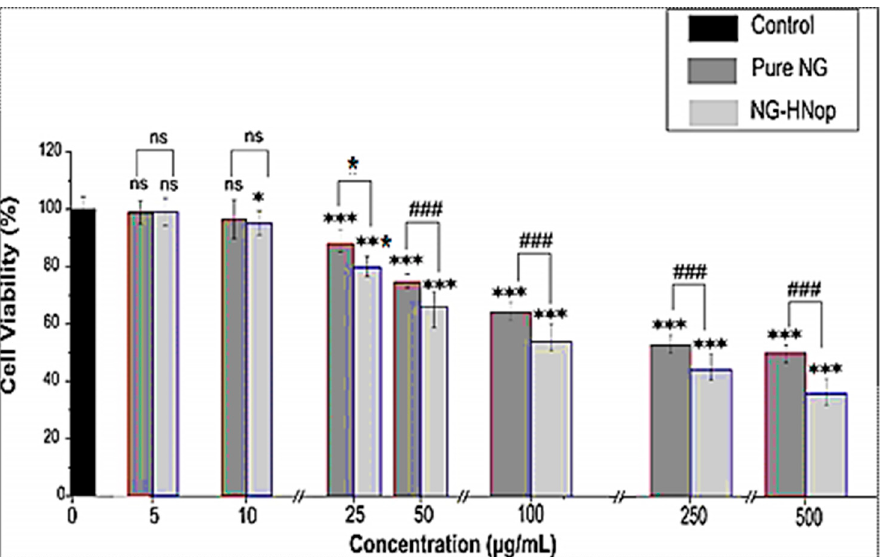
Figure 7. Cell viability activity of pure Naringin (NG) and Naringin hybrid nanoparticles (NG-HNop). The study was performed in triplicate and data are shown as mean ± SD. Statistical analysis was performed by Tukey–Kramer test. ***—Highly significant with respect to control; ###—highly significant with respect to pure NG; *—significant with respect to pure NG; ns—non-significant.